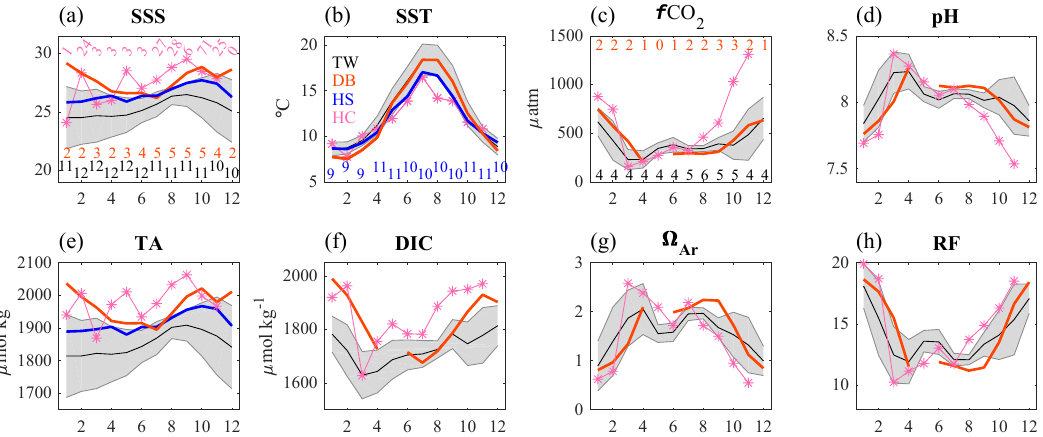
Figure D2. Seasonal cycles of (a) SSS, (b) SST, (c) f CO 2 , (d) pH T , (e) TA, (f) DIC, (g) (cid:127) Ar , and (h) RF at the Twanoh (TW), Dabob Bay (DB), and Hoodsport (HP) moorings and for the Hood Canal (HC) region. Gray shading shows ± 1 σ for TW. Text near the bottom of (a) and (b) indicates the number of years of moored SSS and SST observations contributing to the monthly seasonal cycle estimates. Text in (c) indicates the same information but for the moored f CO 2 observations. Text is staggered in (a) and (b) for viewing. Slanted text in (a) indicates the total number of discrete observations contributing to the monthly seasonal cycle